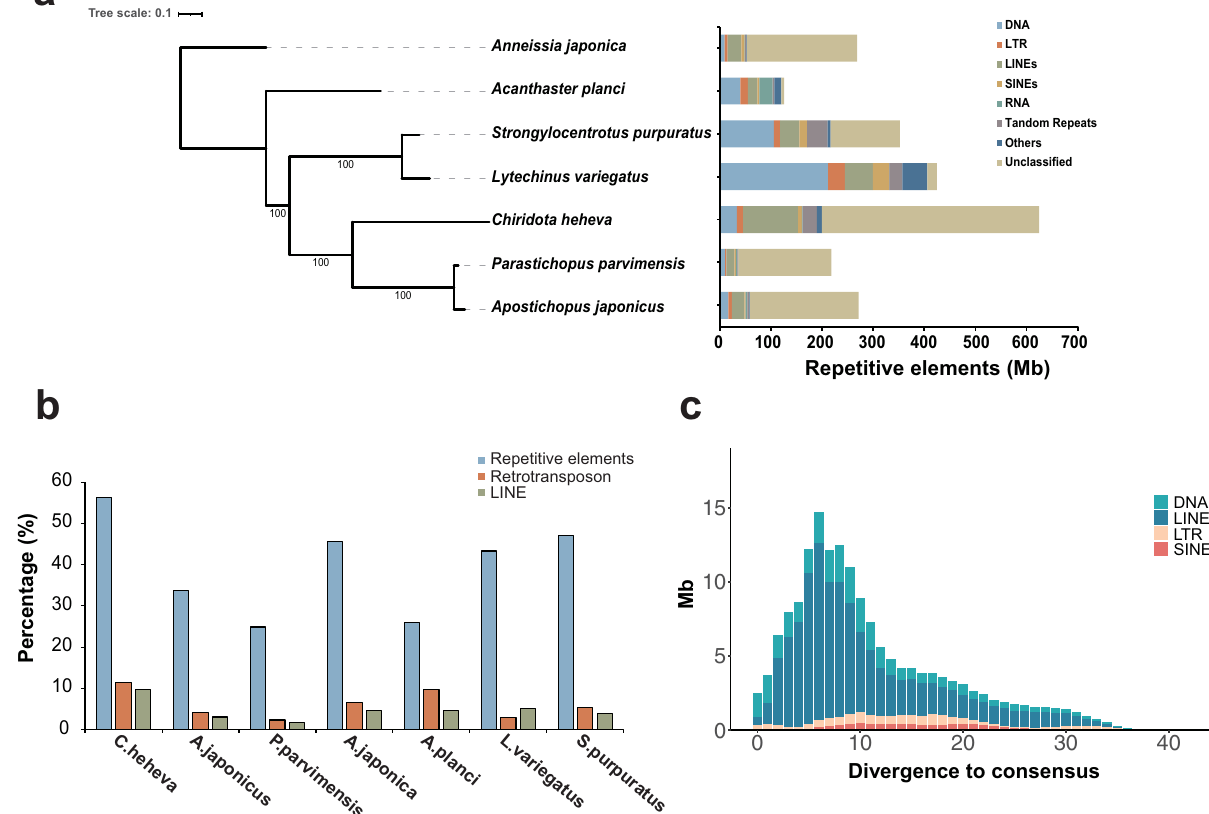
Fig. 2 Landscape of transposable elements in echinoderm genomes. a Comparison of the occurrence and composition of repetitive elements in the genomes of 7 echinoderms. b Comparison of the proportion of repetitive elements, retrotransposon, and long interspersed nuclear elements (LINEs) in the genomes of 7 echinoderms. The proportions of repetitive elements and LINEs are higher in the genome of C. heheva than that in other echinoderms. c Transposable element-accumulation pro fi le in C. heheva genome. A recent burst of LINEs was observed in C. heheva